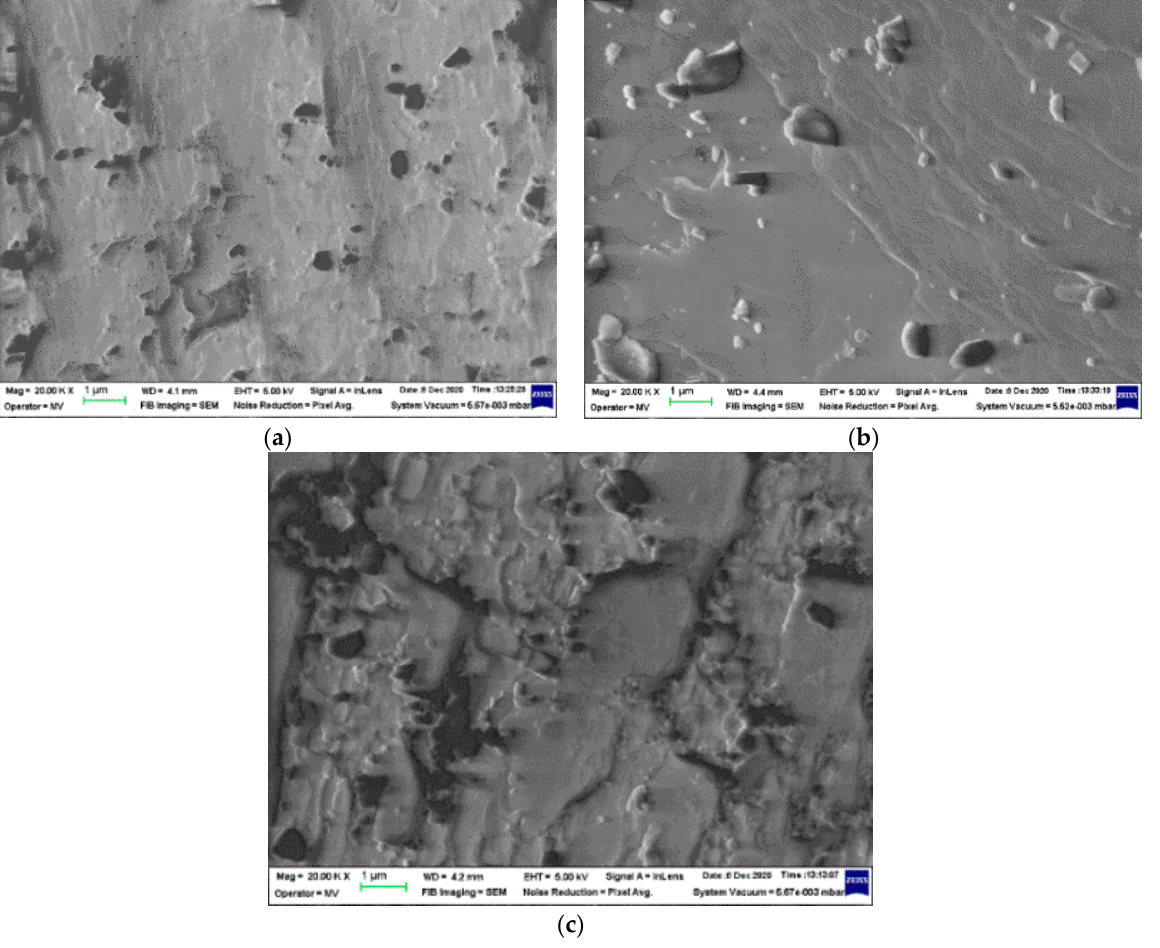
Figure 3. SEM images of Ov-POSS al various radiation processing doses. ( a ) 0 kGy; ( b ) 25 kGy; ( c ) 50 kGy. Magnification 20,000. ( c ) 50 kGy. Magnification